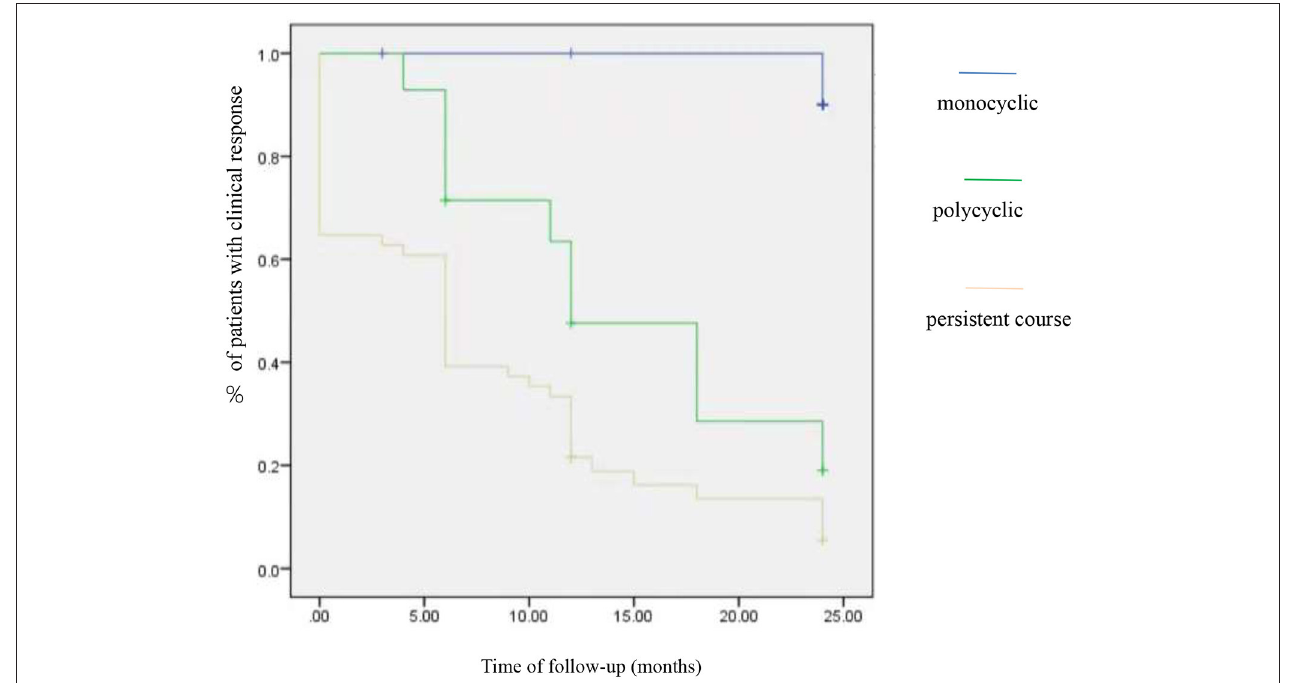
FIGURE 1 | Clinical response with 12 weeks of tocilizumab treatment in different